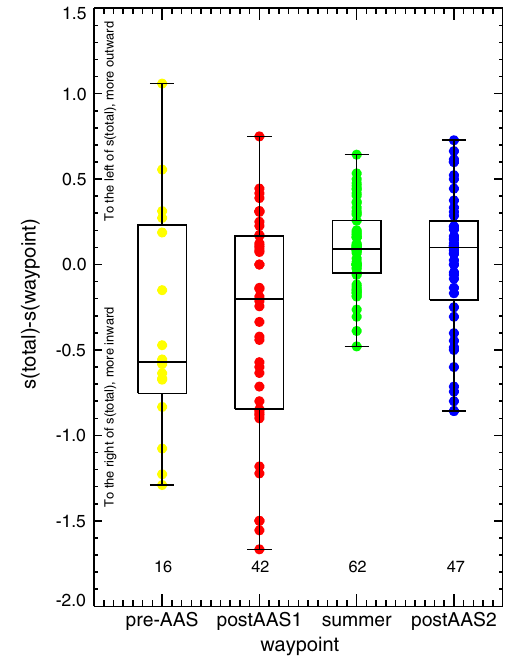
waypoint FIG. 3. Distribution of the offset in s over the year; s was calculated for each teacher at each waypoint ( s ) and waypoint subtracted from s calculated over all available data for each − s < 0 indicate points to the teacher ( s ). Values s total total waypoint right of s (e.g., more inward focused at that waypoint than total − s > 0 are points to the left of s overall), and s total waypoint total (e.g., more outward focused at that waypoint than overall). ¼ 0 , where there is insufficient infor- Instances where s waypoint mation to calculate s , have been omitted from this analysis. Total numbers of encoded surveys available at each waypoint are noted below each box (16, 42, 62, and 47 for the four waypoints, respectively). Box plots are shown on top of each distribution. The median values move up (teachers become more outward focused) with time during the NITARP